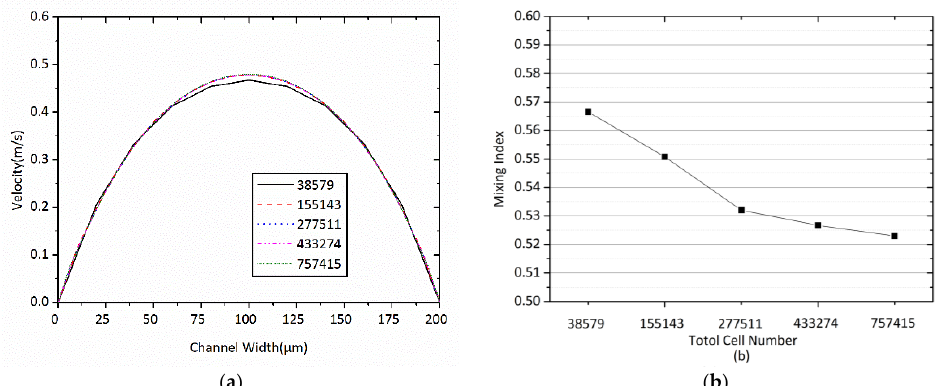
Figure 3. Mesh dependency test for OTM at Re = 50: ( a ) Local velocity profiles along the middle line at the outlet cross section with different mesh refinements, ( b ) Mixing index at the outlet cross section with different mesh refinements.